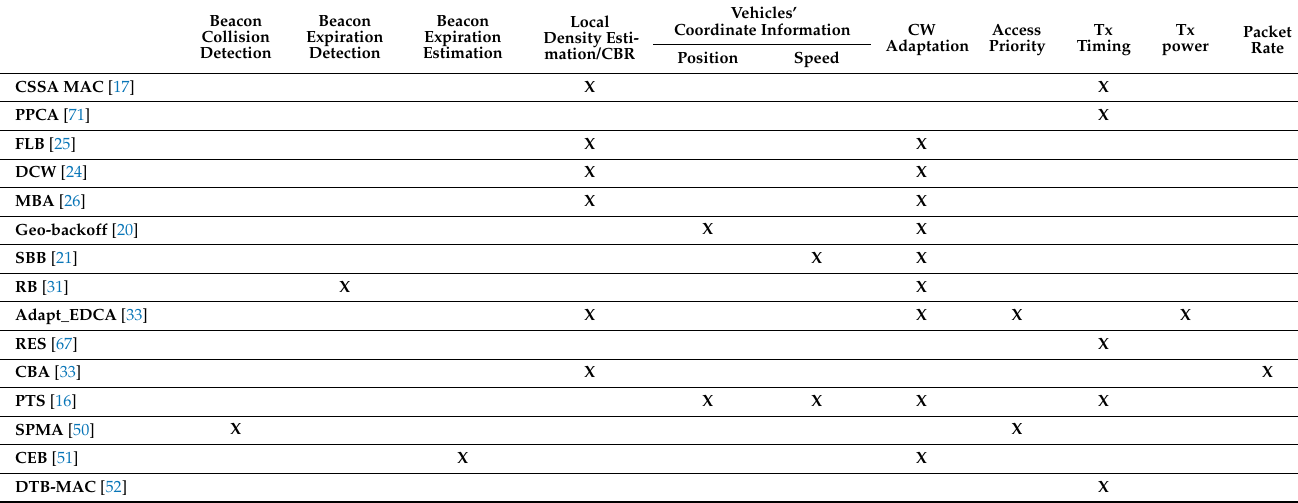
Table 1. Classification of CSMA-like MAC